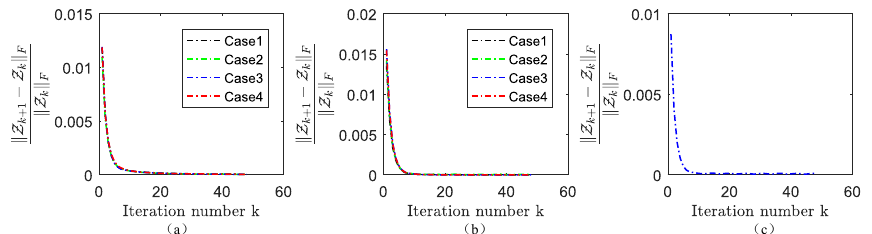
Figure 10. Relative change of Z as a function of the iteration number of the HySuDeep method applied to Pavia University data in ( a ), Washington DC Mall data in ( b ), and Terrain image in ( c